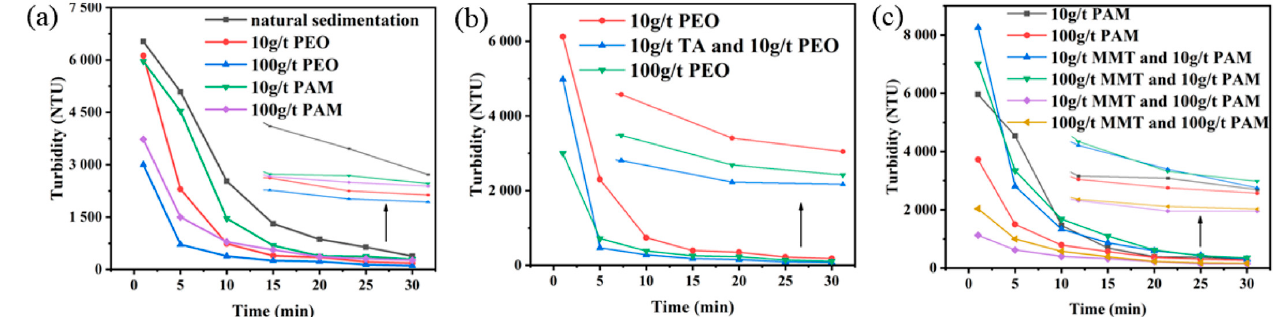
Figure 7. Supernatant turbidity of 1 wt.% -2000-mesh quartz slurry during a 30-min sedimentation: ( a ) high molecule flocculants; ( b ) PEO and cofactor; ( c ) PAM and cofactor.